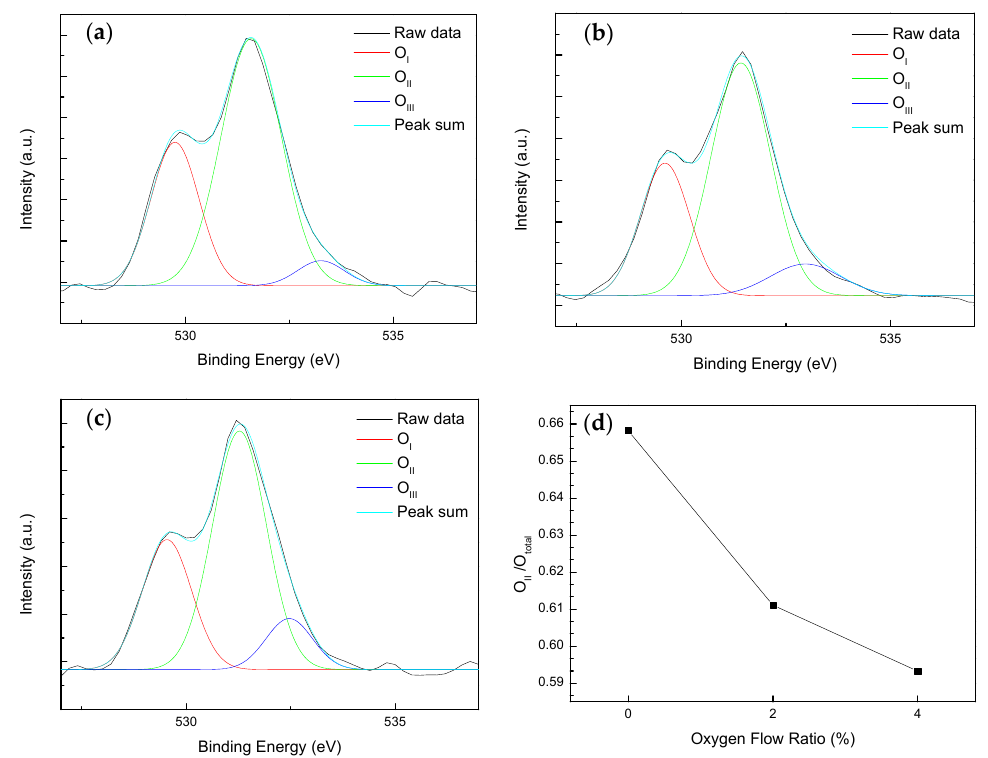
Figure 3. XPS O 1s spectra of MIO thin films with various oxygen flow ratios: ( a ) 0%, ( b ) 2%, ( c ) 4%, ( d ) O II /O total ratios of MIO thin films with various oxygen flow ratios.